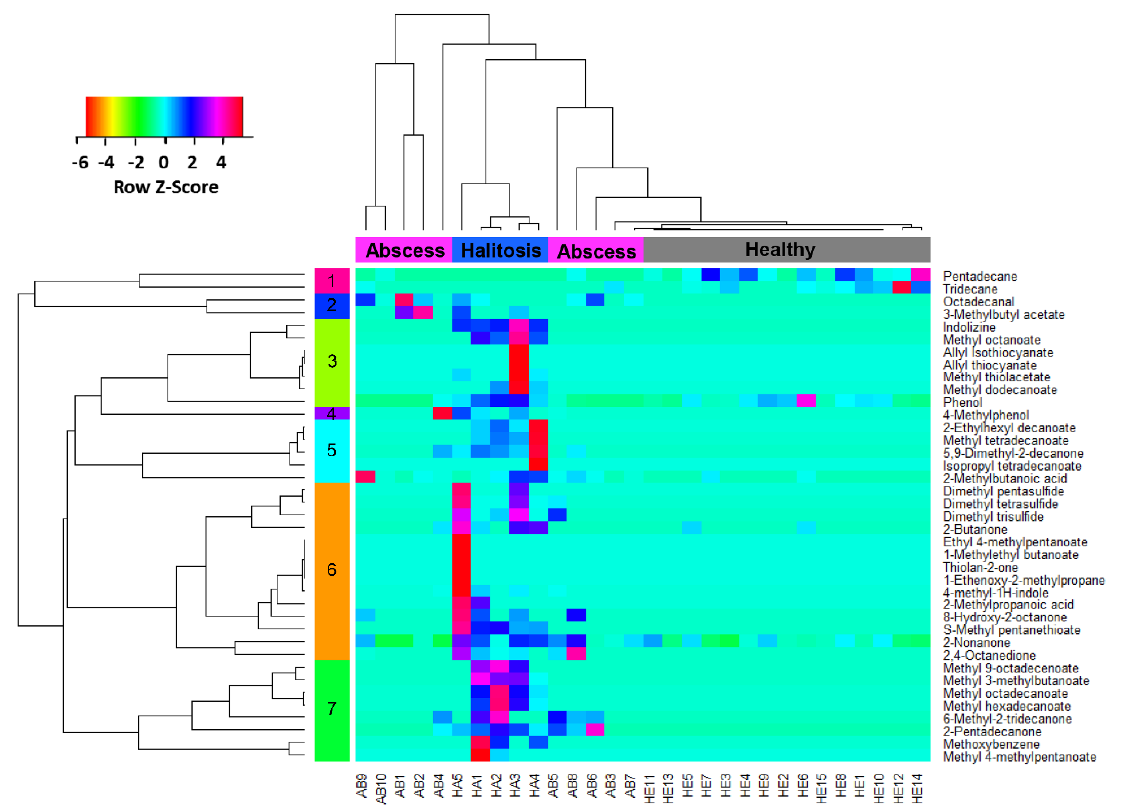
Figure 3. Hierarchical cluster analysis and heatmap of VOC profiles based on peak areas from chromatograms. Columns represent three groups of patients (total of 30 individuals): healthy (15), segregated from an abscess (10) and halitosis (5). Rows represent 39 discriminating VOCs (orange, low abundance; red, high abundance).